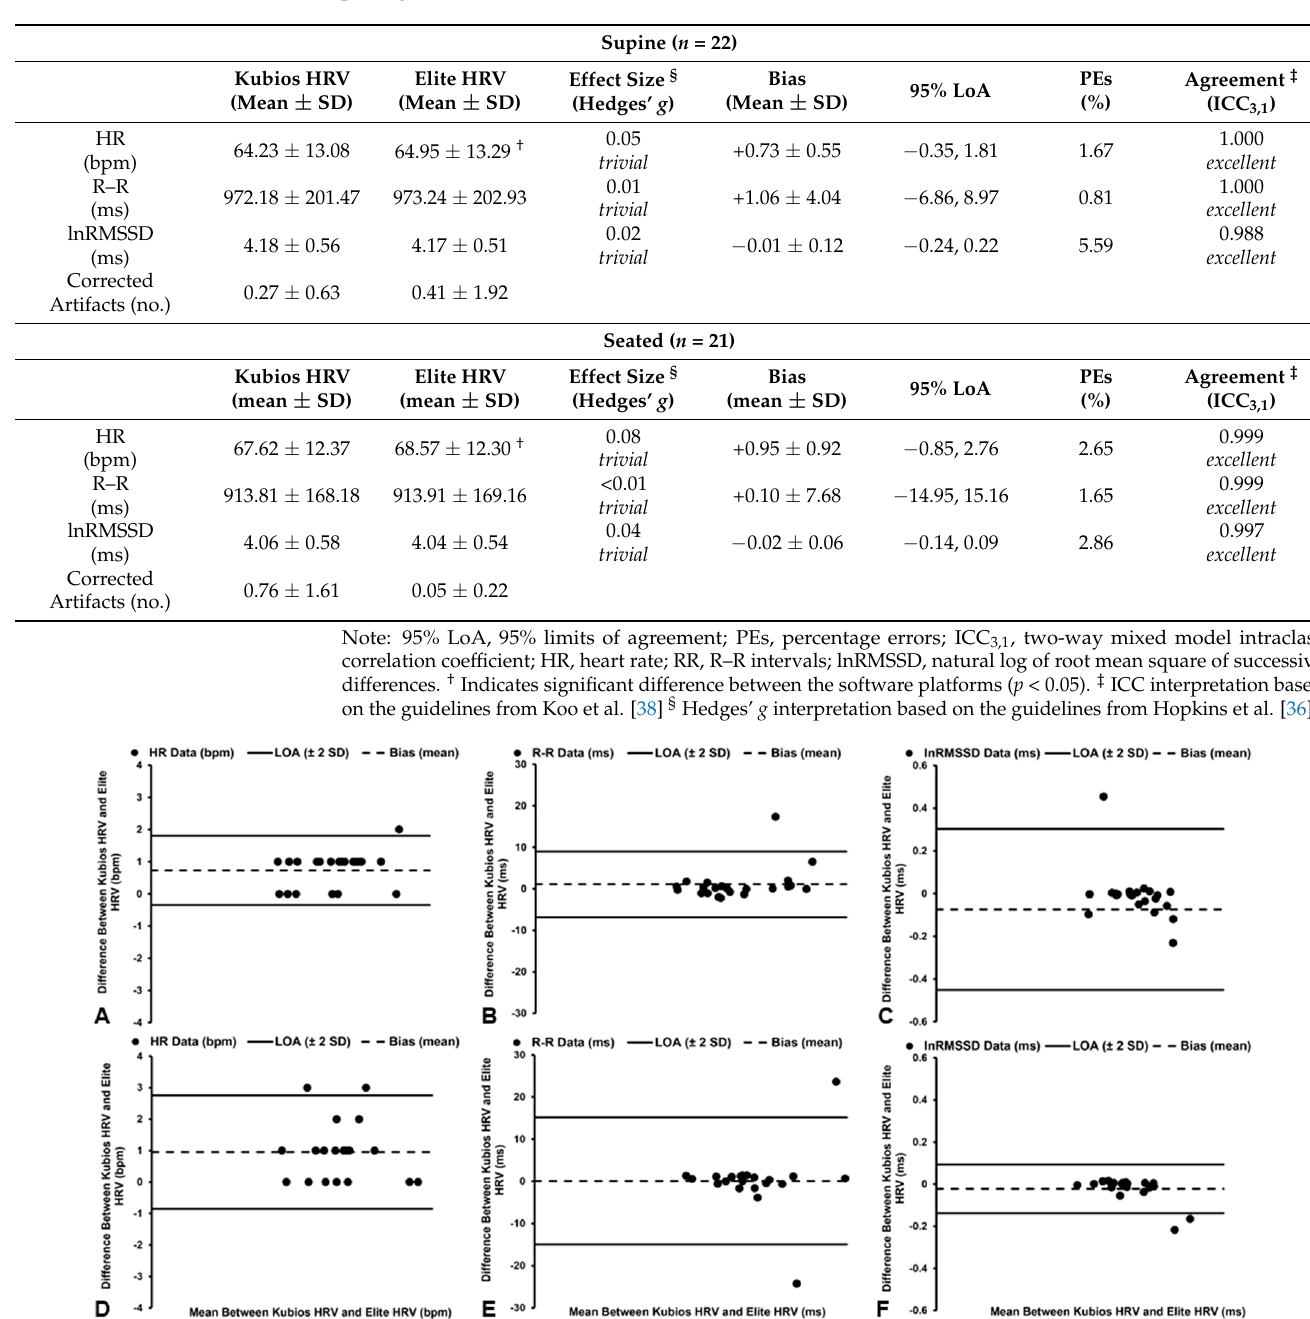
Table 2. Very Low Correction Level—Descriptive data, bias, error, and agreement between software packages.